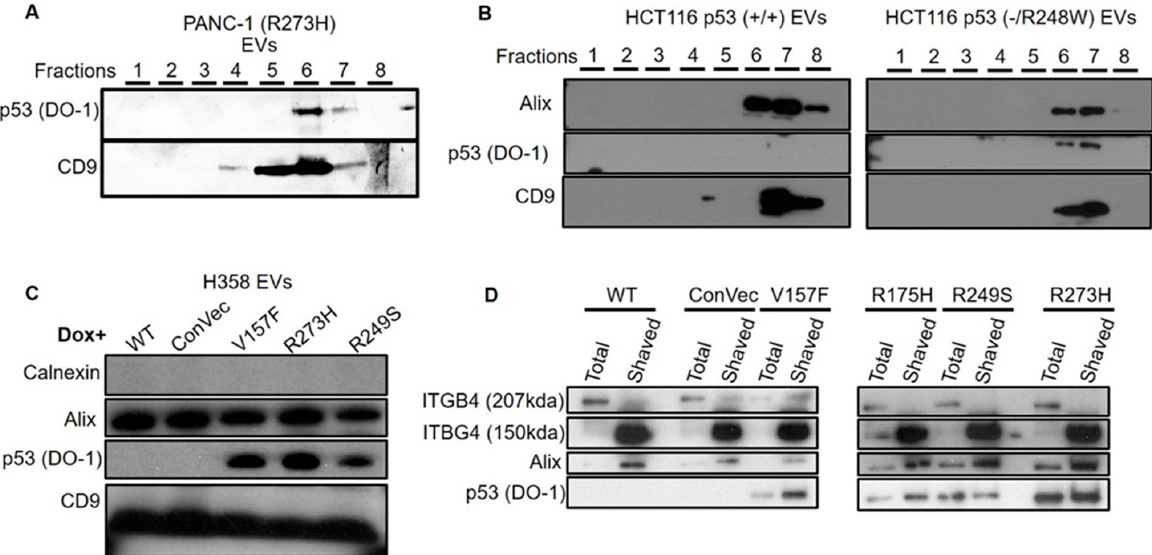
Figure 2. Mutant p53 proteins are sorted into EVs shed by cancer cells. EVs from several cancer cell lines harboring mutant p53 were isolated and their lysates were tested for the presence of the mutant p53 protein in WB. ( A ) Sucrose gradient (8 fractions) of PANC-1 cells harboring the p53 mutant R273H. ( B ) Sucrose gradient (8 fractions) of EVs from HCT116 cells expressing WT (+/+) p53 were compared to EVs from HCT116 cells harboring the mutant p53 ( − /R248W). ( C ) EVs from H358 cells with Tet-On system expressing different p53 forms (ConVec = empty vector, no p53) CD9 and Alix were used as EV markers; calnexin was used as a cellular marker for confirming that no cellular contamination is present ( D ) EVs from H358 were treated with enzymatic proteolysis shaving of the external proteins. “Total”—no shaving treatment; “shaved”—with shaving treatment. ITBG4 was used as an external EV marker, while Alix was used as an internal EV